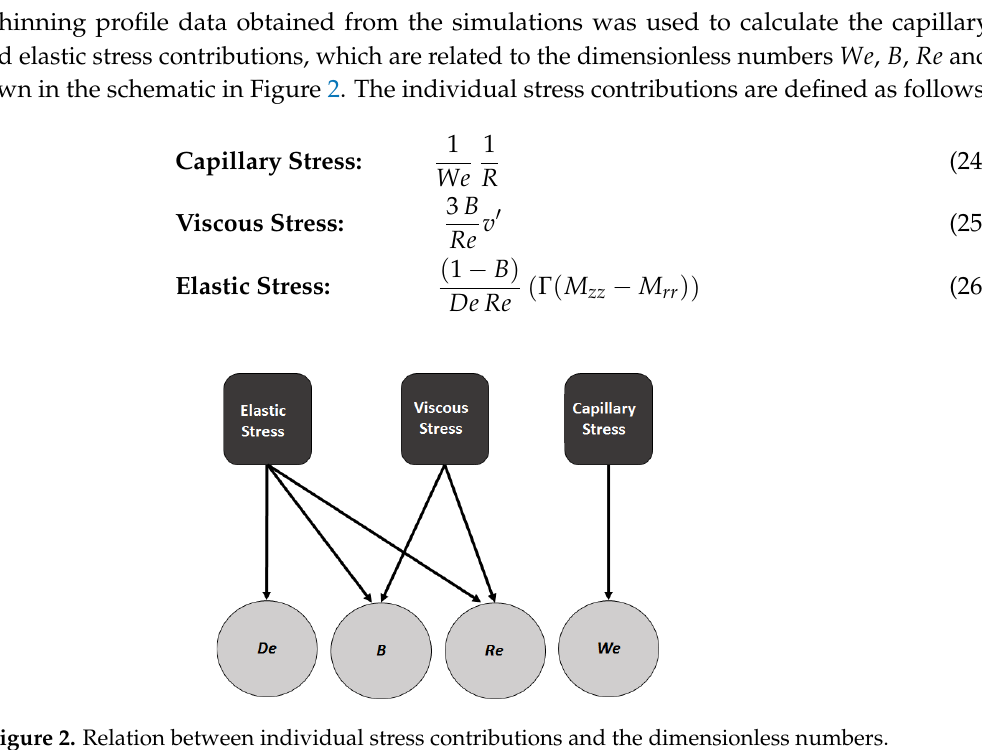
Figure 2. Relation between individual stress contributions and the dimensionless